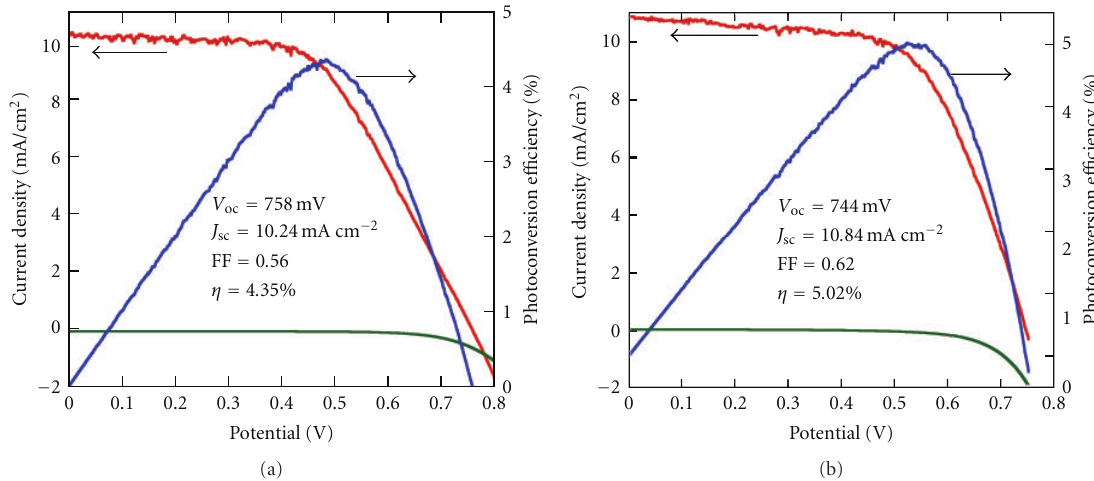
Figure 23: Photocurrent density, dark current density, and power density of 2.0 μ m long rutile TiO 2 nanowire-array-based dye-sensitized solar cells under AM 1.5 illumination (100mW/cm 2 ): (a) unmodified nanowire array grown directly on TCO substrate and (b) a TiCl 4 treatment is used to coat the TCO substrate prior to nanowire array growth and a NbCl 5 treatment used on the nanowires prior to device assembly. Reprinted with permission from [24]. Table 3: Statistics of TiO 2 nanowire arrays dye-sensitized solar cells showing the mean ( μ ), and standard deviation ( σ ) of the solar cell parameters: Short Circuit Photocurrent Density ( J sc ), Open Circuit Voltage ( V oc ), Fill Factor, and E ffi ciency ( η ) [102]. Length of nanowires ( μ m) Typical nanowires width